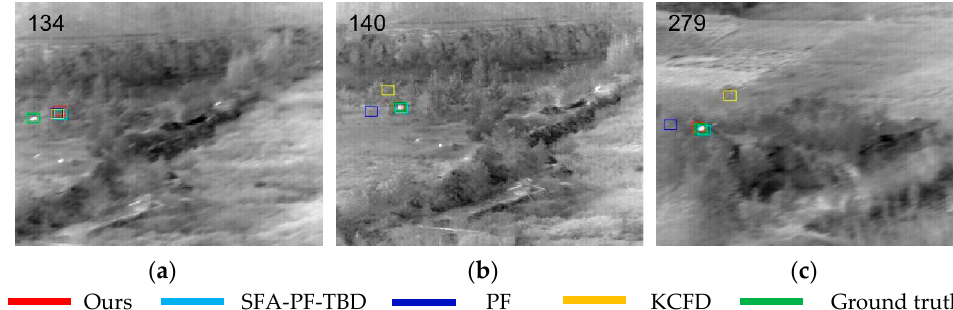
Figure 3. Tracking results of four methods for data16. ( a ) Results at frame 134; ( b ) results at frame 140; ( c ) results at frame 279.